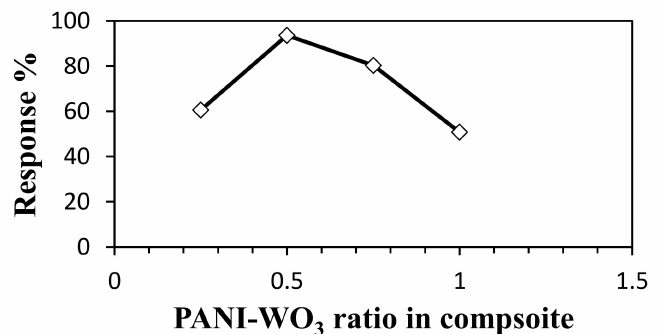
Figure 21. Change in response of PANI/WO 3 /CuCl 2 -based sensors with varying ratio of PANI and WO 3